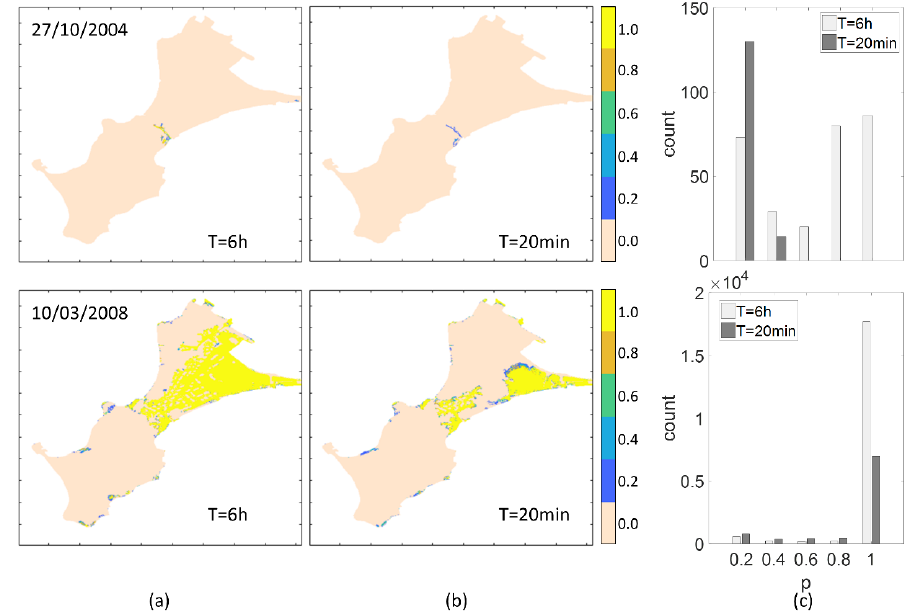
Figure 10. Flood probability map for the ( a ) E6hS and ( b ) E20mS runs. ( c ) Resulting flood probability (denoted p ) histogram (count corresponds to the number of cells). Probabilities p are computed based on 5 simulations for each event.